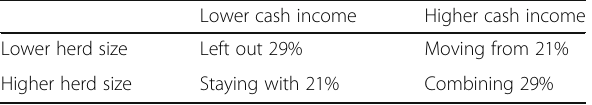
Table 1 Livelihood groups in the study region